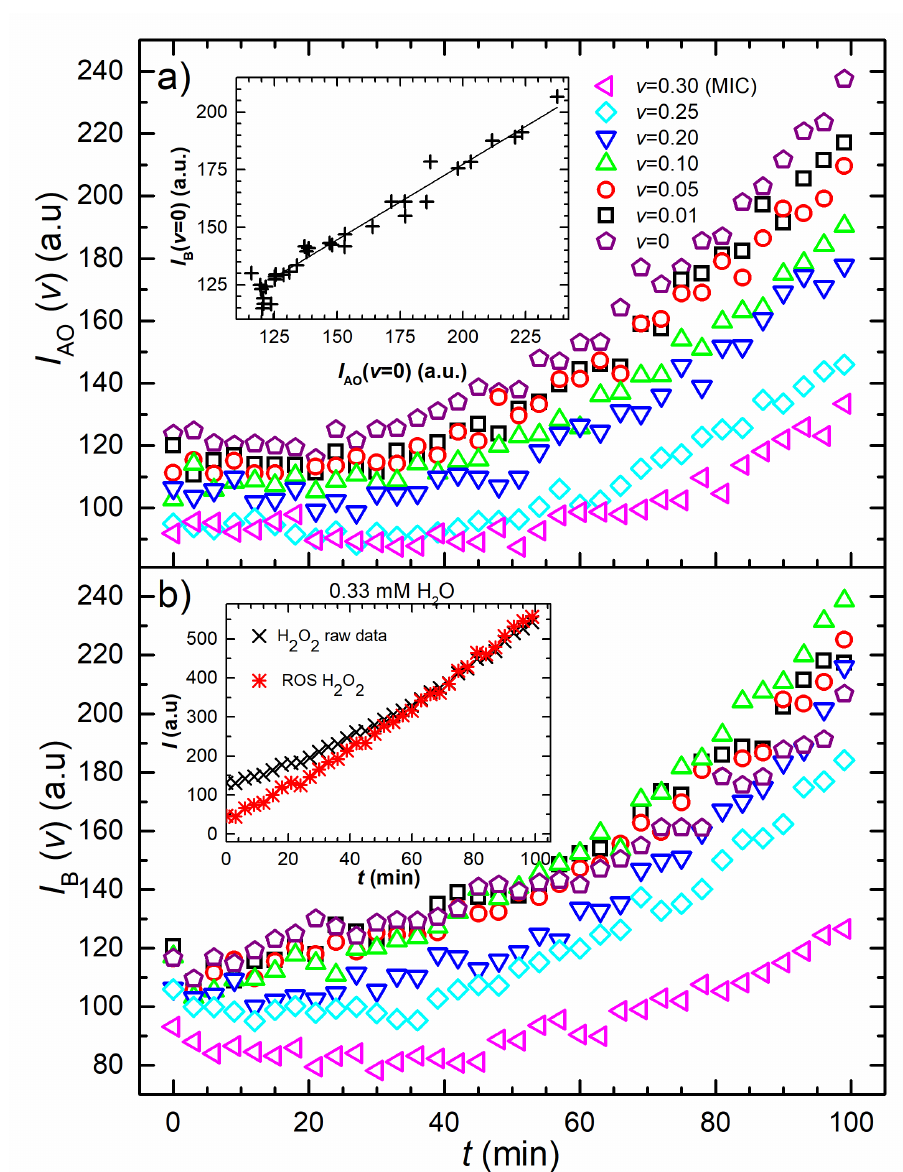
Figure 2. Evolution of the raw fluorescence data . ( a ) Raw fluorescence intensity versus time. Time dependence of the fluorescence signal developed when the DCFH 2 -DA dye is diluted in non-inoculated PBS and mixed with the produced colloid. The legend reveals AgNPs concentrations in the mixture. The inset shows the correlation between the non-inoculated and inoculated samples raw fluorescence data that are AgNP-free ( v = 0) and its linear fit. ( b ) Raw fluorescence intensity versus time. Time development of the fluorescence signal of the same mixture given in ( a ) when inoculated with E. coli cells. The cross-shaped symbols in the inset are the raw fluorescence signal of H 2 O 2 treated E. coli cells and the double cross-shaped symbols are the cellular ROS